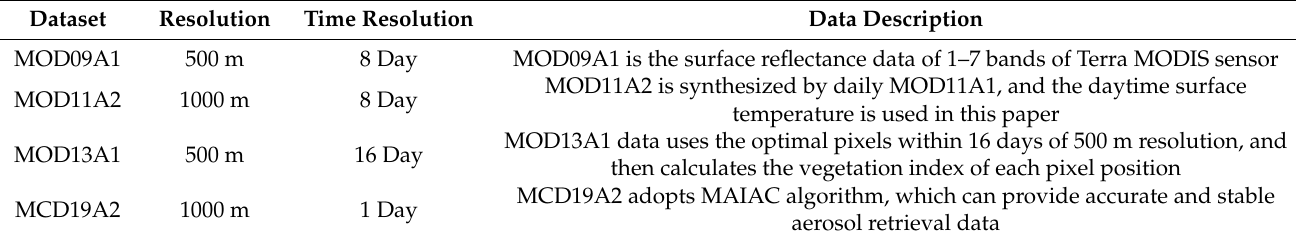
Table 1. The data source of five ecological components.